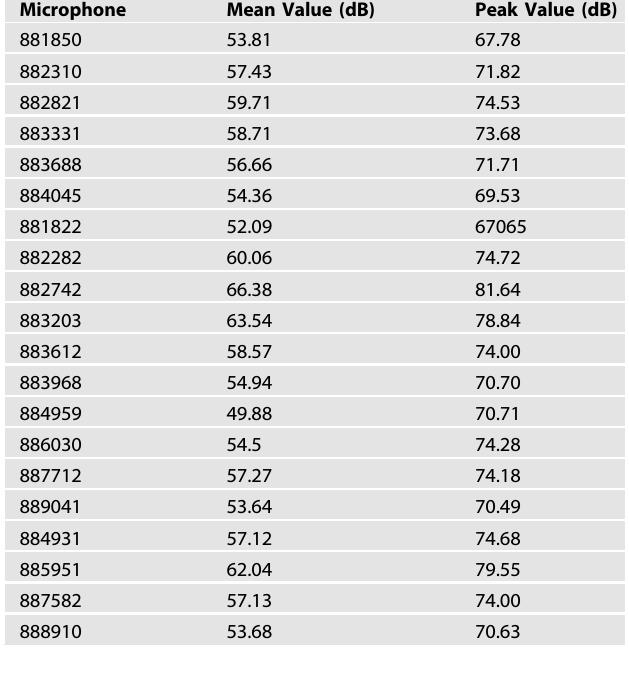
Table 3. The microphone measurements.